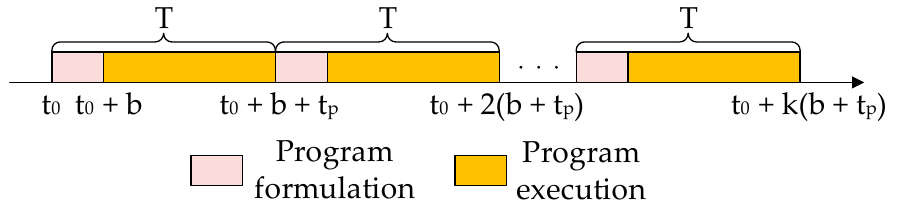
Figure 2. Online scheduling process.